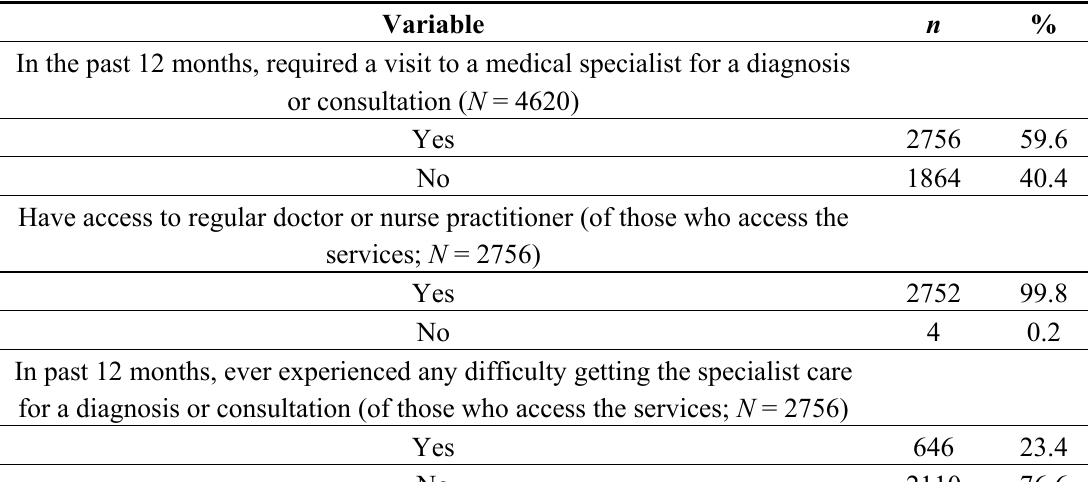
Table 1. Frequency of access and distance to healthcare services within the Saskatchewan Rural Health Study (SRHS) households.